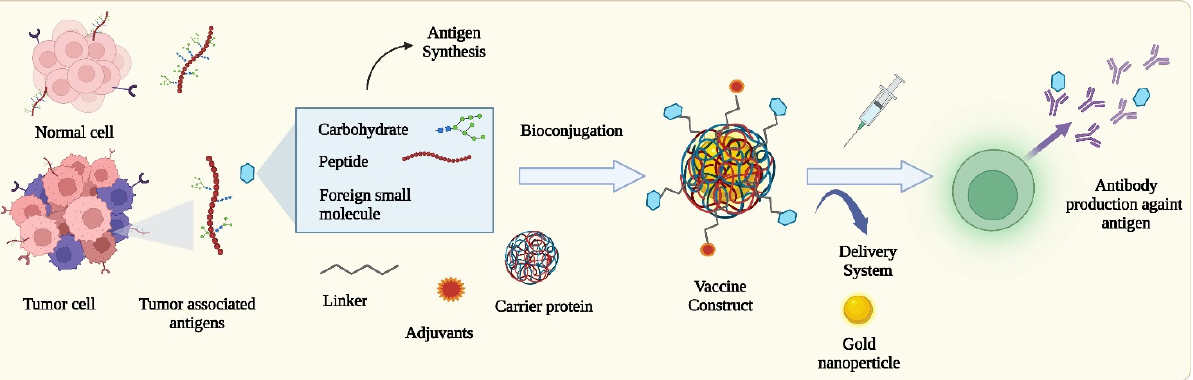
Figure 2. Strategies for tumor antigen-based cancer vaccine development. TAs are overexpressed on the surface of tumor cells due to mutations. These antigens can be synthesized or bioconjugated with carrier proteins by using specific linkers to construct the vaccines. Adjuvants and various delivery systems have been employed to boost the immunogenicity and deliver the vaccines more effectively. Cancer vaccines motivate the production of antibodies against specific TAs on tumor cells.